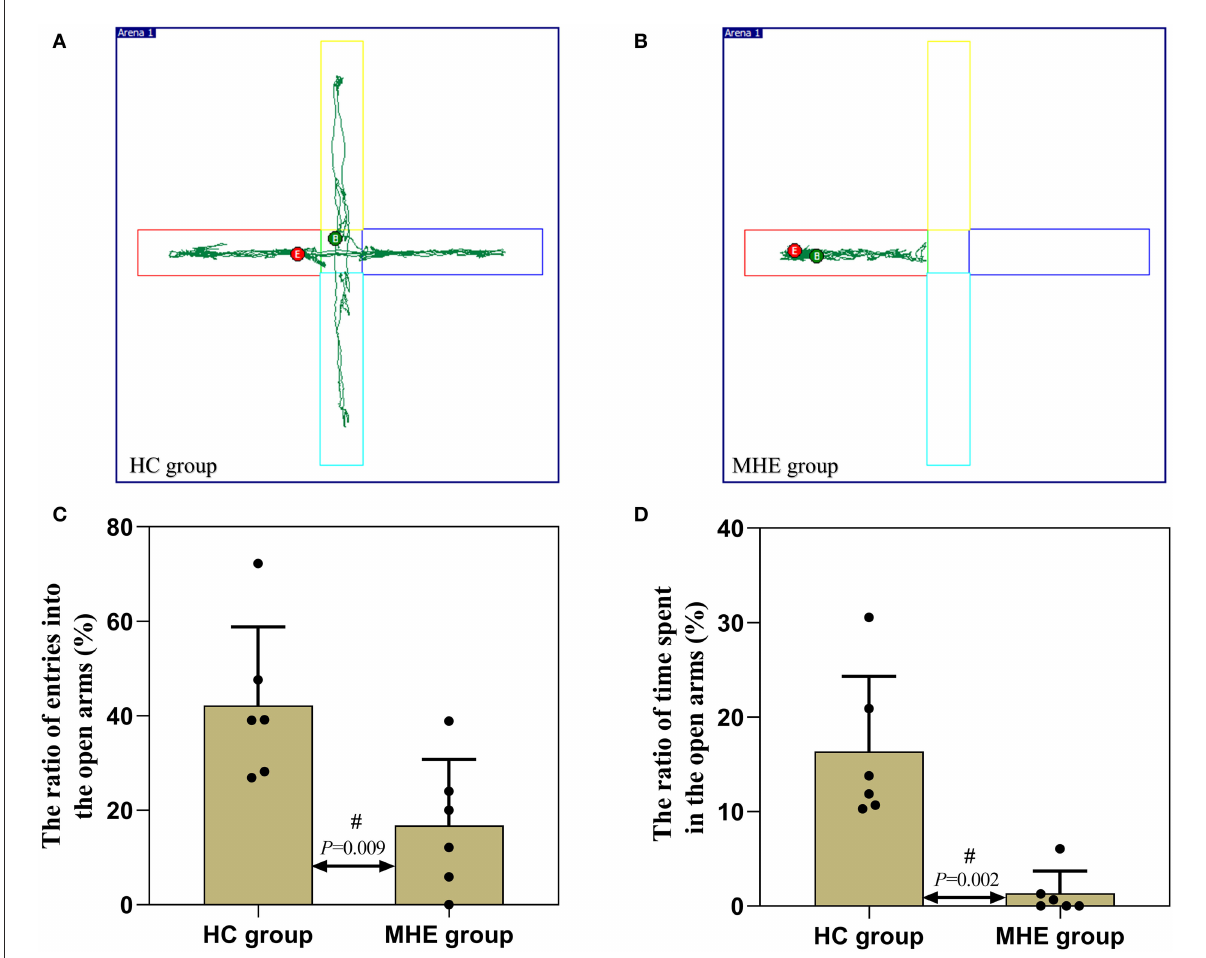
FIGURE5 Autonomic activity and exploratory behavior of MHE and control rats. (A,B) are the representative trace in the elevated plus maze task; (C) The ratio of entries into the open arms; (D) The ratio of time spent in the open arms; # Mann-Whitney U